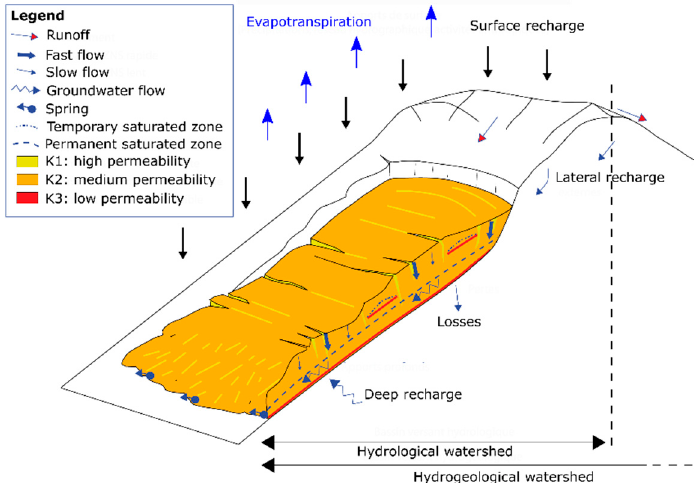
Figure 1. Synthetic diagram of a landslide’s hydrological and hydrogeological functioning.